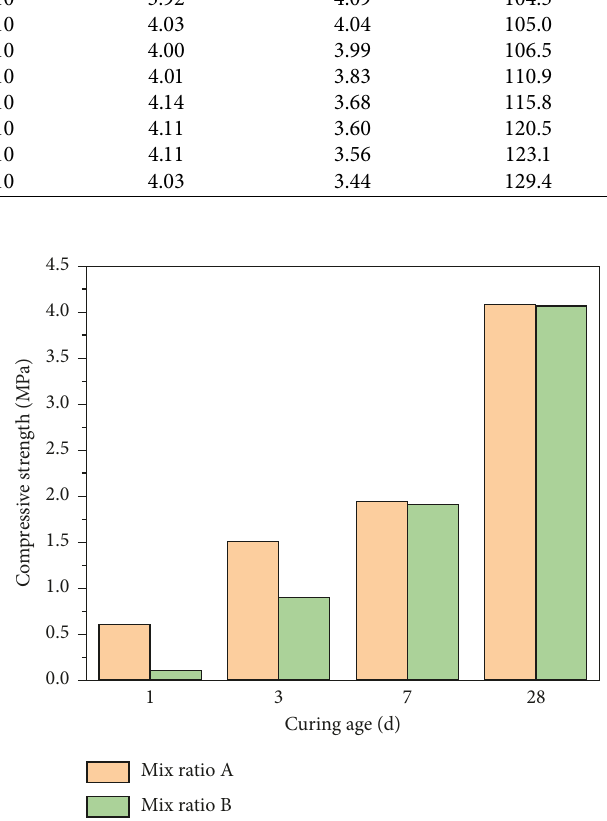
Figure 14: Compressive strength of various curing ages of the optimal mix ratio of filling